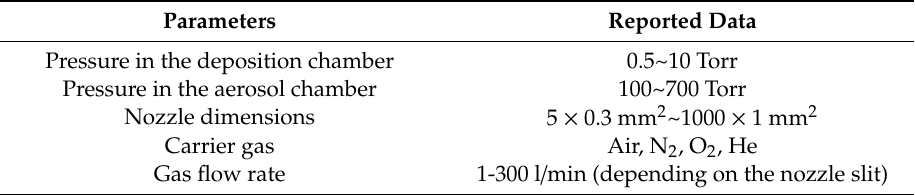
Figure 4. Schematic of AD apparatus. Table 1. Important parameters for AD experiments.